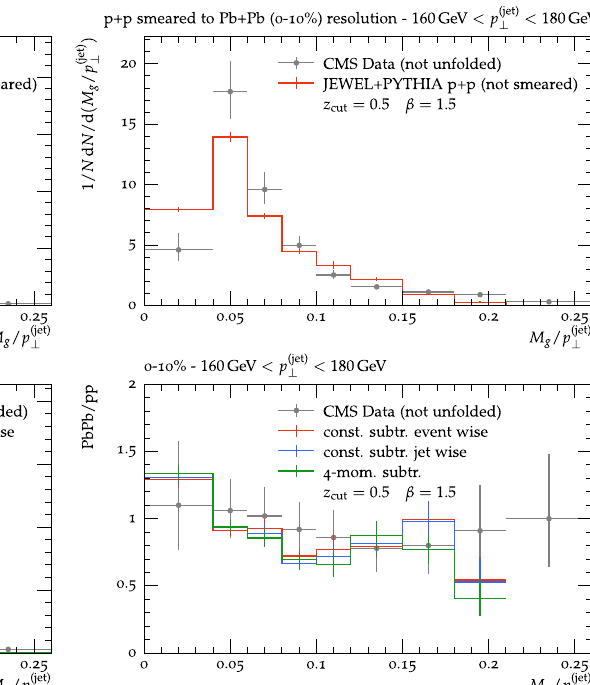
Fig. 6 Groomed jet mass divided by (un-groomed) jet p ⊥ distribu- tions for p+p (top left), p+p smeared to 0–10% Pb+Pb resolution (top right), 0–10% Pb+Pb (bottom left) and Pb+Pb (0–10%) divided by smeared p+p (bottom right). The SoftDrop parameters are z cut = 0 . 5 and β = 1 . 5 and the jets are anti- k ⊥ jets with R = 0 . 4, | η jet) | < 1 . 6 and